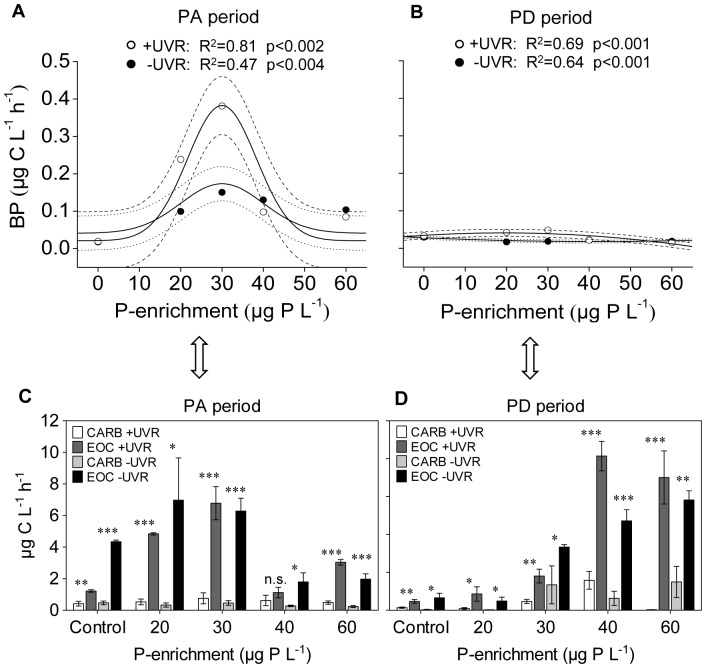
Non-linear regressions between BP and P enrichment, and bacterial requirements vs. supply of algal carbon.Dashed and dotted lines indicate 95% interval confidence for each regression, fitted as in Figure 2 in the PA period (A) and PD period (B). Photosynthetic carbon required by bacteria (CARB) and excretion of organic carbon from algae (EOC) measured in the PA (C) and PD (D) periods. Error bars are standard deviations. Significance of Student’s t-test between CARB and EOC for each experimental treatment: *p<0.05; **p<0.01; ***p<0.001. (PA period: phosphorus-availability period; PD period: phosphorus-depletion period).